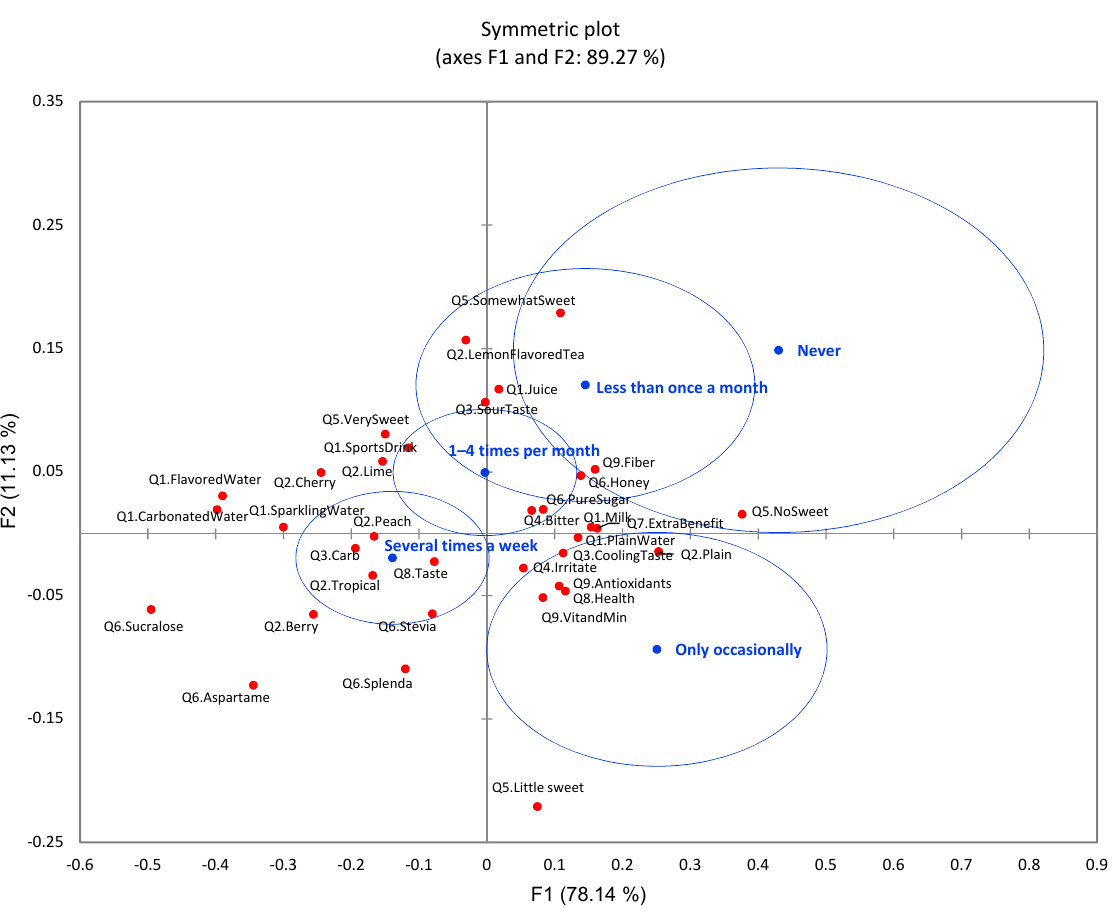
Figure 12. The first two dimensions of correspondence analysis (CA) symmetric plot using drink frequency (never, only occasionally, less than once a month, 1–4 times per month, and several times a week) as rows and all nine survey questions as columns ( n = 901) (5 rows × 37 columns). Confidence ellipses on the plot were automatically created by XLSTAT software based on CA with observed χ 2 = 414.84 and p < 0.0001.